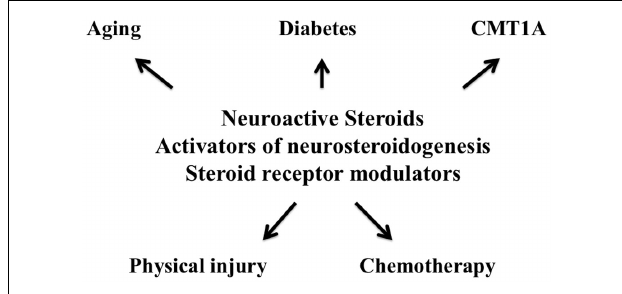
FIGURE 2 | Pathological targets of neuroactive steroids in the peripheral nervous